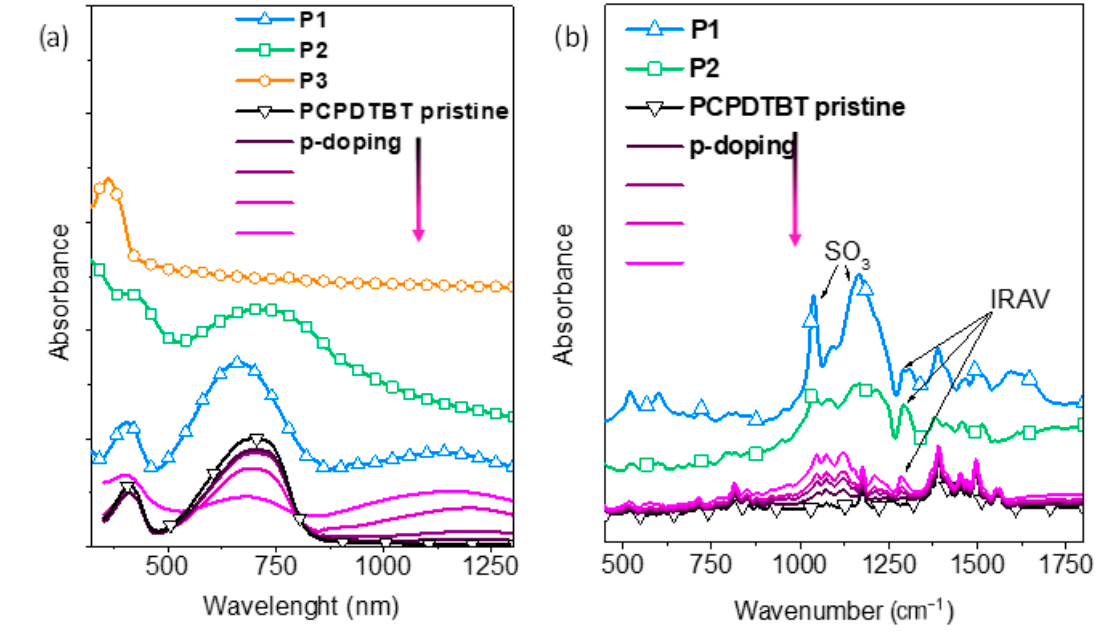
Figure 3. ( a ) UV/Vis-NIR absorption spectra of P1 , P2 , and P3 films and ( b ) IR absorption spectra of P2 and P3 films with a pristine PCPDTBT film during its p-doping through I2 vapor exposure.